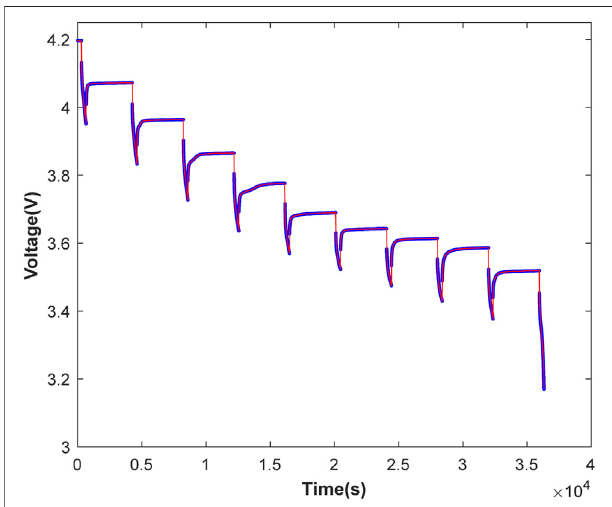
FIGURE 5 | Battery discharge voltage curve in the HPPC